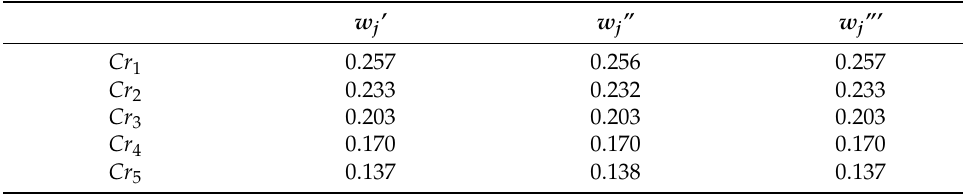
Table 11. The criteria weight obtained using three approaches.